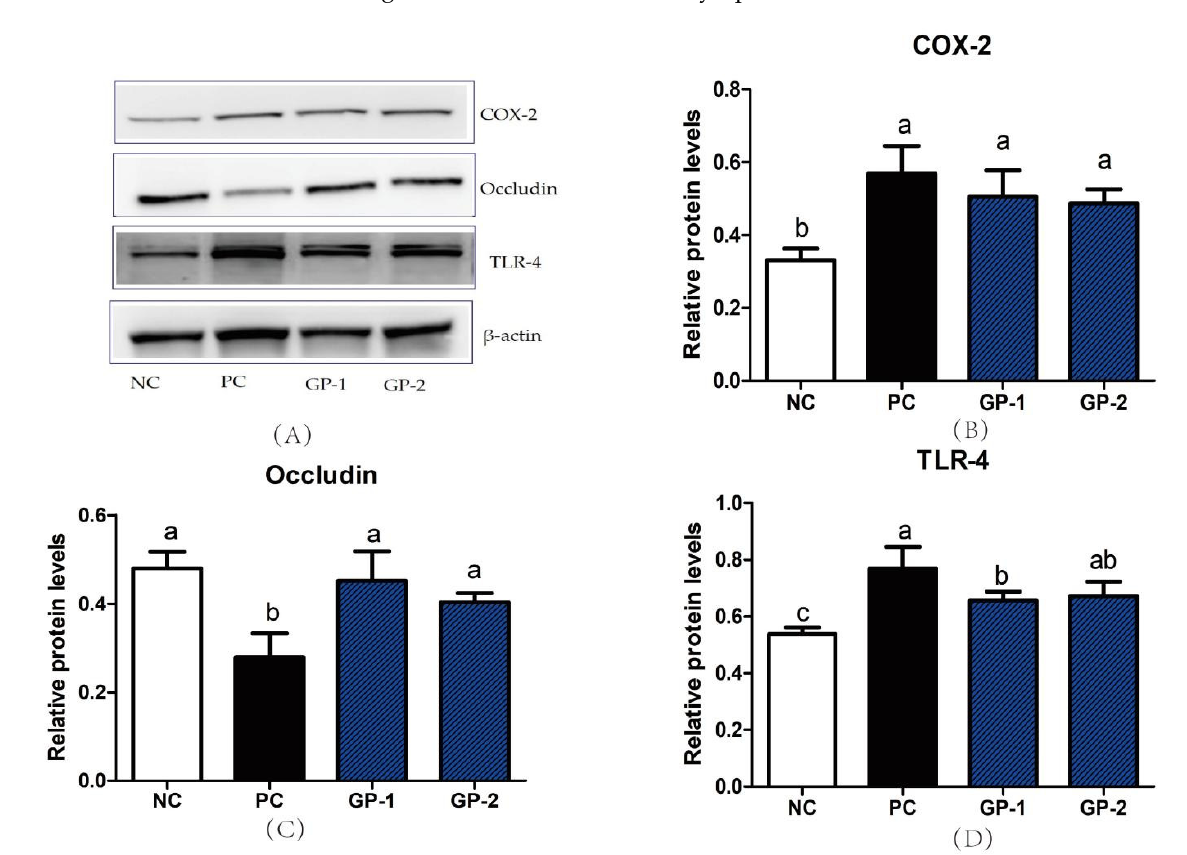
Figure 7. Western blot of proteins in colon. All the proteins were analyzed with the comparison of β -actin. The protein bands in Western blot analysis ( A ). The expression of COX-2 ( B ), Occludin ( C ) and TLR-4 ( D ). All values represent the means ± SD ( n = 4) and the different letters mean significant differences of p < 0.05 by the analysis of one-way ANOVA (Tukey’s Multiple Comparison Test).